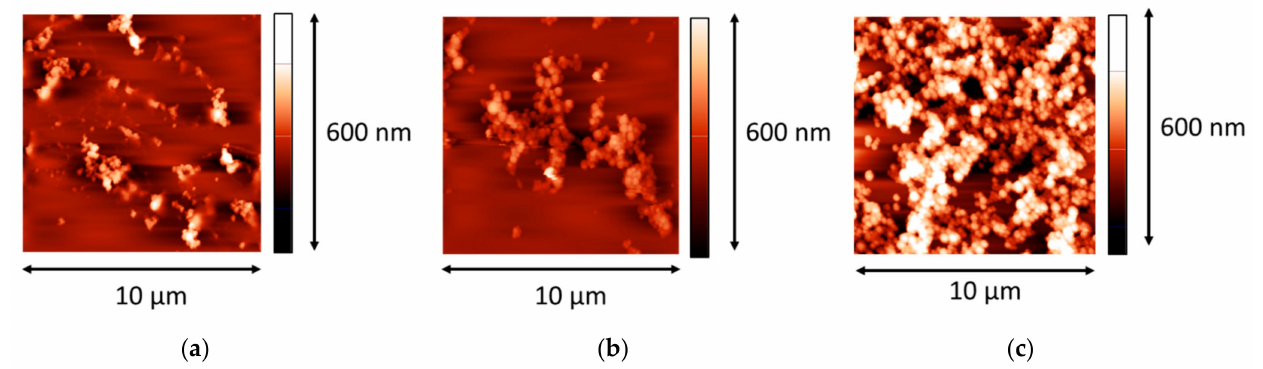
Figure 5. AFM images of spread LYS microgel layers at the surface of 0.1 M NaCl at pH 10. ( a ) corresponds to a dispersion without purification, ( b , c ) correspond to dispersions after two and three cycles of purification, respectively. The microgel layers were transferred onto a mica surface after ten-fold